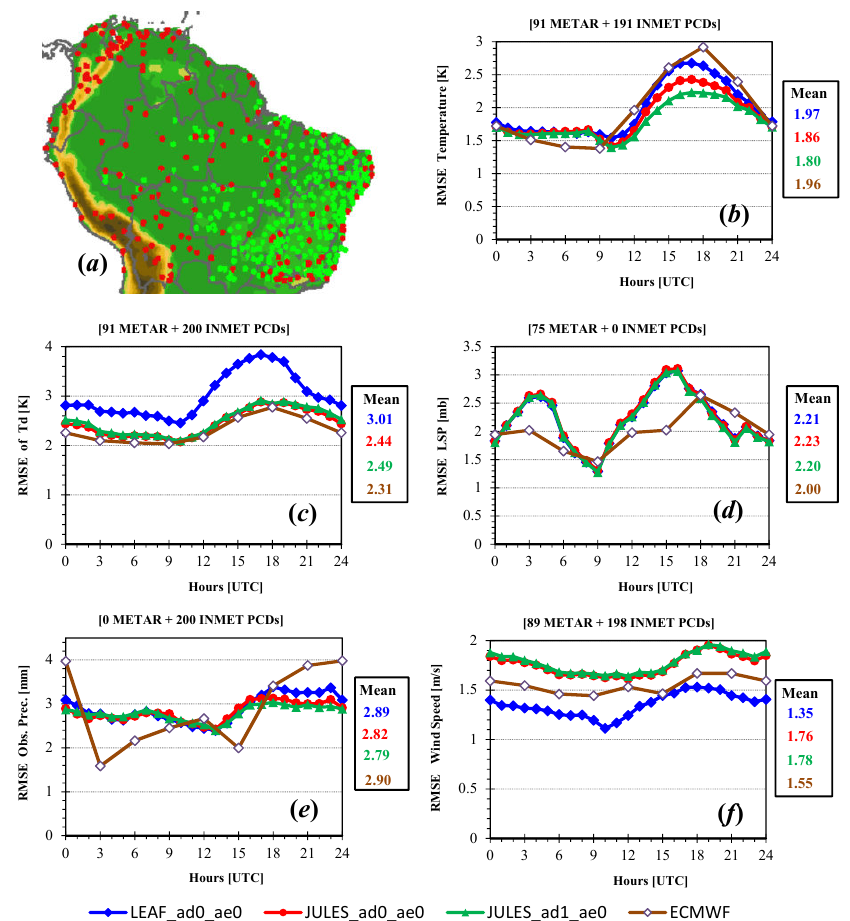
Fig. 4. Geographic locations of the conventional airport stations (red points) and automatic stations (green points) (a) . Root-mean-squared error for the variables: air temperature at 2m (b) ; dew point temperature at 2m (c) ; pressure reduced to mean sea level (d) ; six-hour accumulated precipitation (e) ; and wind speed at 10m (f) – for the period from 1 to 31 March 2010. Brown line refers to ECMWF reanalyses and other lines are from JULES-CCATT-BRAMS model disregarding the presence of aerosol (ae0), where the blue and red lines used LEAF and JULES surface model with non-monotonic advection (ad0), respectively, and the green line used JULES surface model with monotonic advection